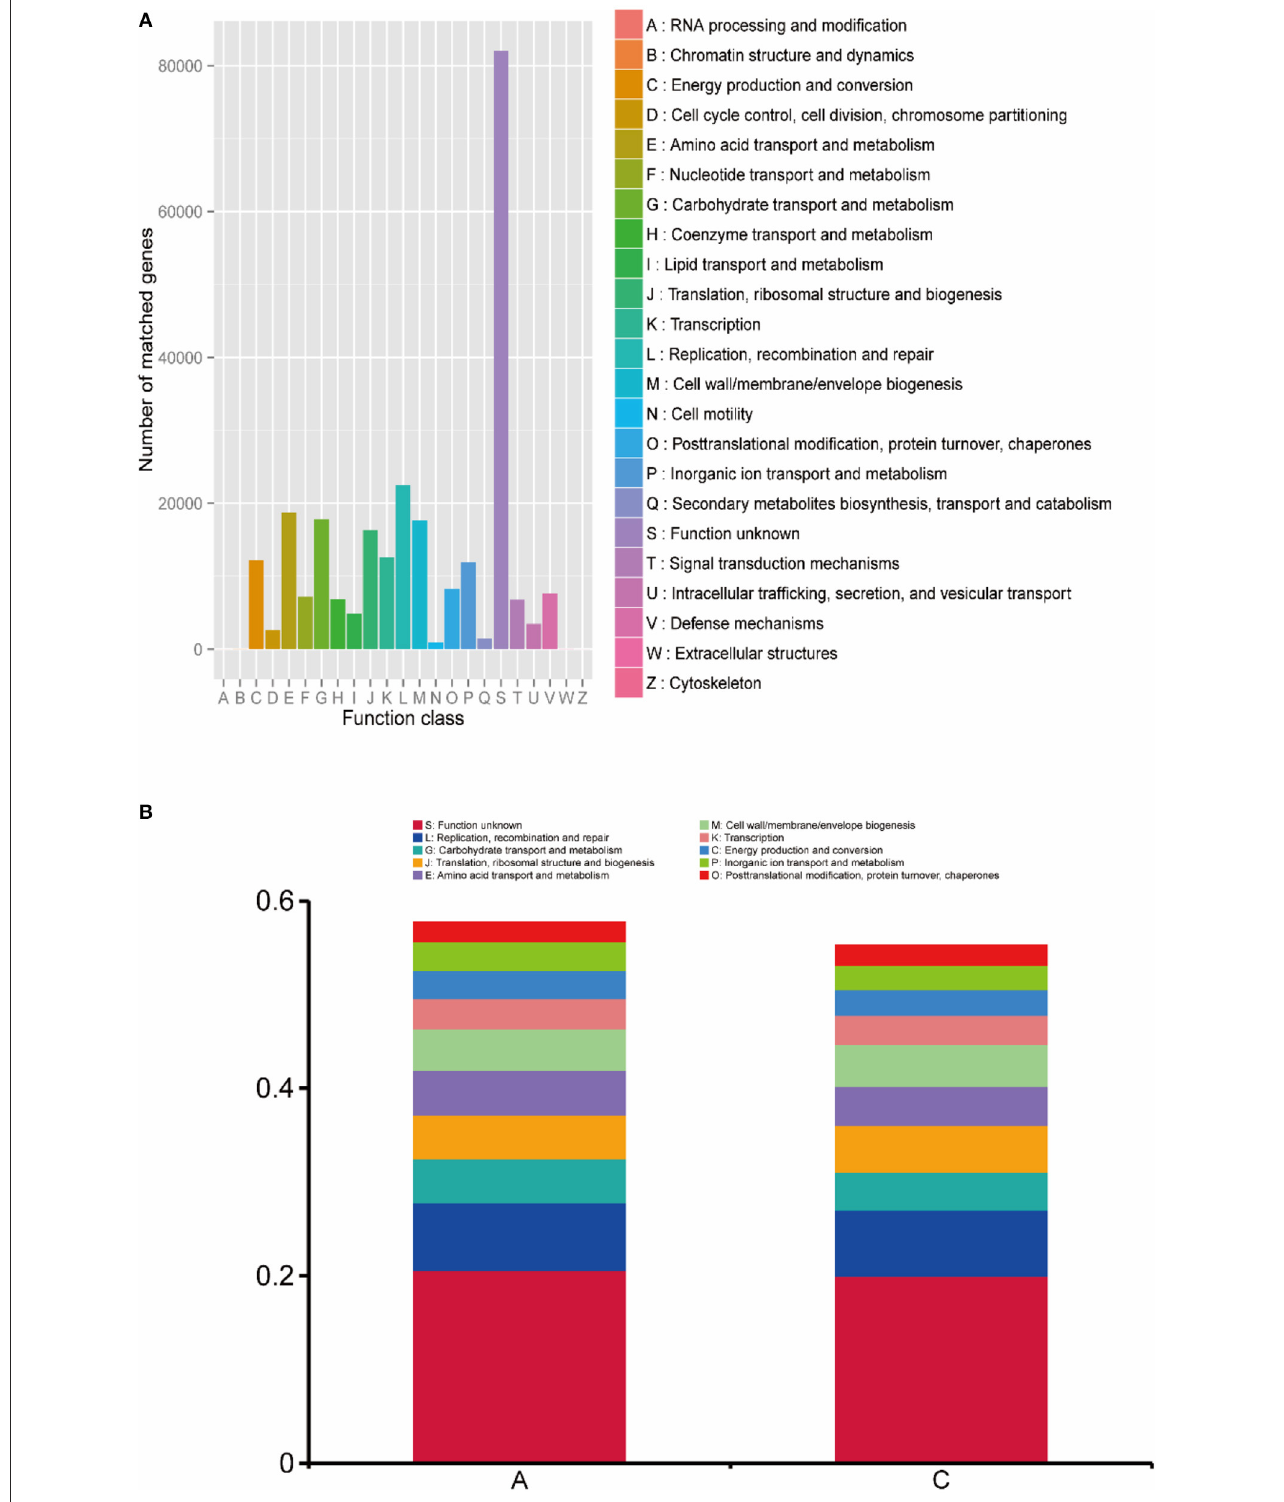
FIGURE6 (A) Statistics of the number of gene annotations based on the eggNOG database; (B) the histogram of functional abundance on level 1 based on the KEGG